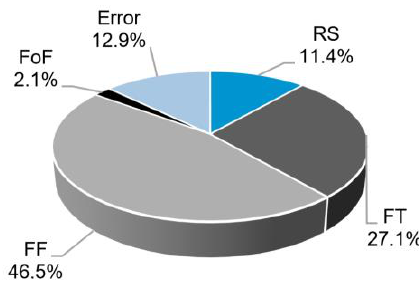
Figure 13. Contributions of the model factors to the response W.